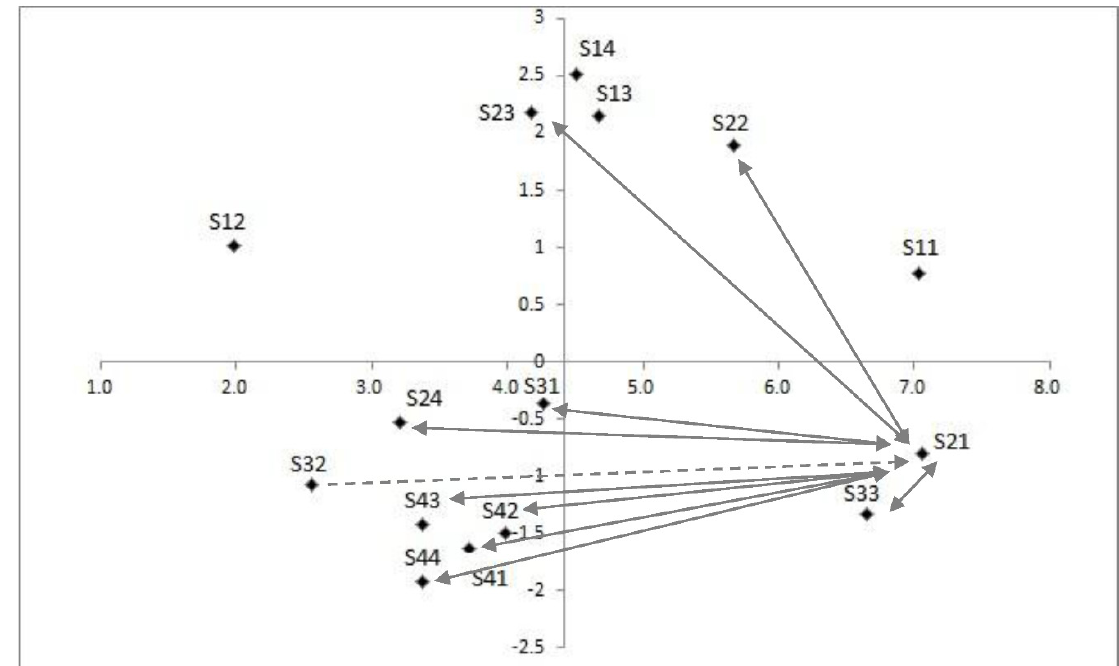
Figure A5. Casual Diagram between S21 and Other Criteria.